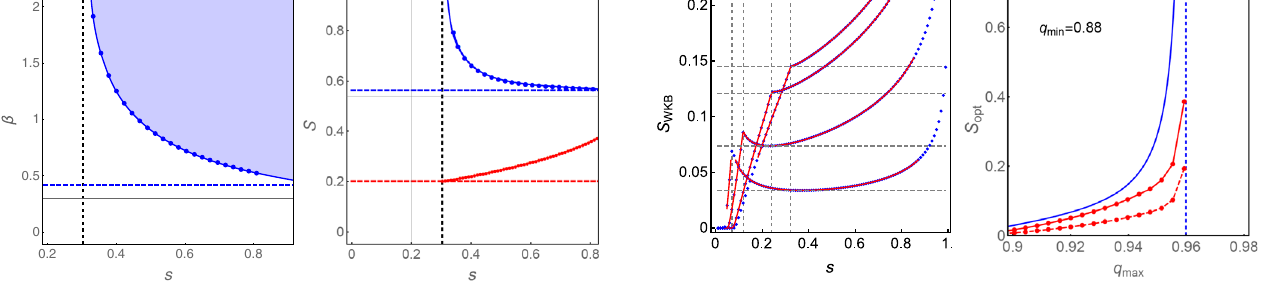
FIG. 5. Left panel: Quantum mechanical tunneling action at FIG. 4. Left panel: Inverse critical temperature dependence on s Þ for q 0 . 88 , q 0 . 955 . vanishing temperature in the incoherent regime as a function of the transverse-field strength β PT ð min ¼ max ¼ the transverse-field parameter s . Different curves correspond to The horizontal dashed line corresponds to the classical transition 0 . 929 , 0.946, 0.958, 0.961 (order is different values of q temperature, and the vertical dashed line marks the point of max ¼ from bottom to top on the right side of the plot) with fixed the quantum phase transition. Right panel: Comparison of the q 0 . 9 . Note that the optimal tunneling rate emphasized by vanishing temperature quantum-tunneling action to that of the min ¼ the horizontal dashed lines does not always correspond to the classical over-the barrier escape. The blue line shows optimal phase-transition point denoted by vertical dashed lines. Right over-the-barrier escape action along the critical lineshown in the 0 . 88 panel: Optimal action for SA (blue) and QA (red) at q left panel. Blue points correspond to the same values of s as in the min ¼ for different values of q [see Eqs. (19) and (20) and the text left figure. The horizontal blue line corresponds to the transition max for details]. The dashed red line corresponds to the coherent rate at the critical temperature in the classical model, s ¼ 1 . quantum-tunneling action (scaling as 1 = 2 of the action in the The vertical line corresponds to the point of zero-temperature incoherent regime). The vertical dashed line corresponds to quantum phase transition. The red line corresponds to the 3 q q , at which point the classical potential has a vanishing temperature limit of the quantum-tunneling action. 2 min ¼ max degenerate ground state at q ¼ q and q ¼ 1 . At this point, The red horizontal dashed line corresponds to the minimum min both the SA action and the QA action diverge; however, the QA of the quantum-tunneling action at the quantum phase transition action diverges logarithmically slow, in contrast to the SA action. point. The local exhaustive search corresponds to ξ ¼ ð 1 =N Þ log τ Q q ≈ 0 . 227 , larger than the quantum For the parameters chosen, the local exhaustive search corre- es ¼ cl ð min Þ Q q ≈ 0 . 227 , which is sponds to ξ ¼ ð 1 =N Þ log τ annealing time. es ¼ cl ð min Þ